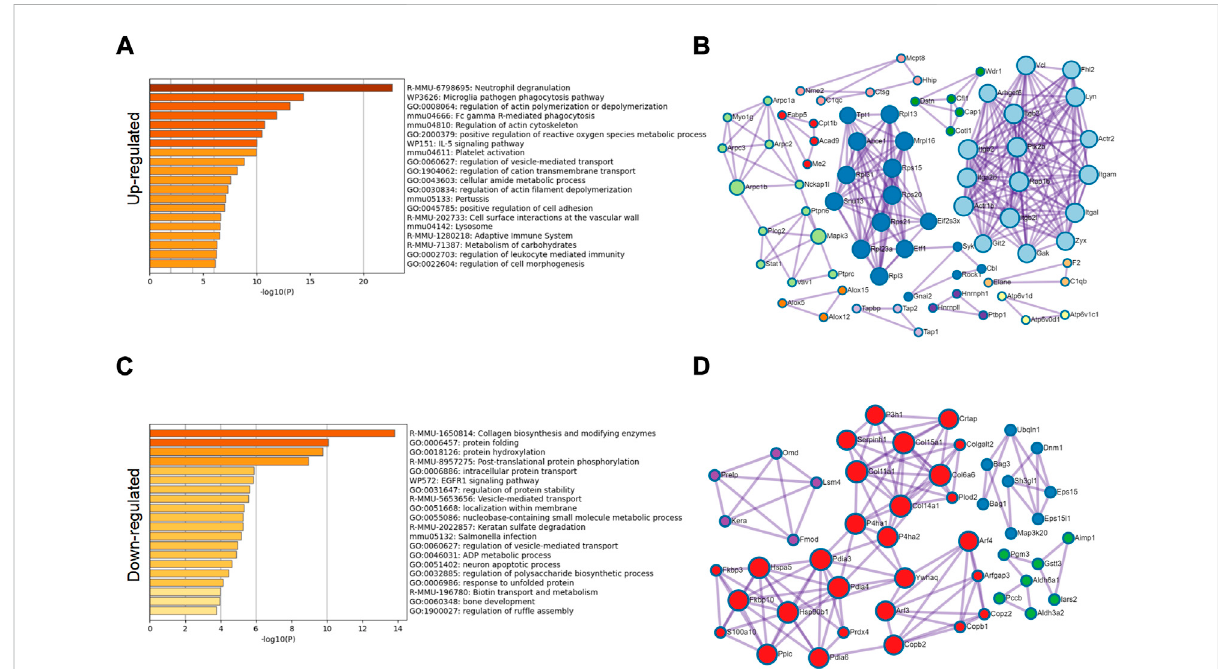
FIGURE 4 GO classi fi cation of signi fi cantly different proteins. (A) GO classi fi cation of 276 signi fi cantly upregulated proteins. (B) Network diagram analysis of upregulated proteins. (C) GO classi fi cation of 202 signi fi cantly downregulated proteins. (D) Network diagram analysis of downregulated